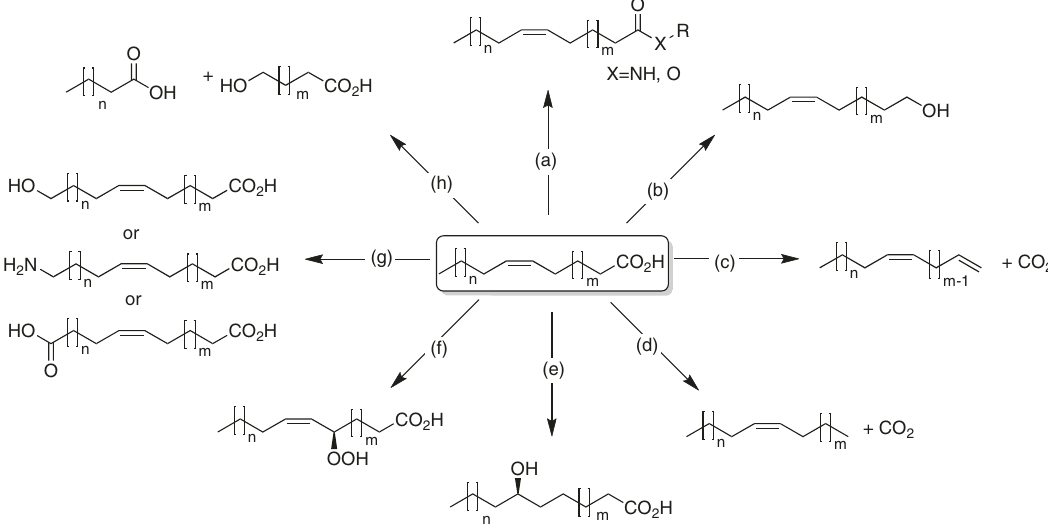
Fig. 1 Natural fatty acids as building blocks. In recent years, biocatalytic methodologies for the transformation of fatty acids have practically exploded. For example: a hydrolase-catalysed esteri fi cation of amidation 4 , b reductase-catalysed reduction of the carboxylate group to the corresponding aldehyde and alcohol 30,31 , c P450-peroxygenase-catalysed oxidative decarboxylation yielding terminal alkenes 5 – 7 , d photodecarboxylase-catalysed decarboxylation yielding alkanes 38,39 , e hydratase-catalysed water addition to C = C-bonds 50 , f lipoxygenase-catalysed allylic hydroperoxidation 21 , g use of mono-, di- and per-oxygenases for the terminal hydroxylation and further transformation into acids or amines as polymer building blocks 15 – 18,51 , and h multi-enzyme cascades yielding short-chain acids 22 – 27